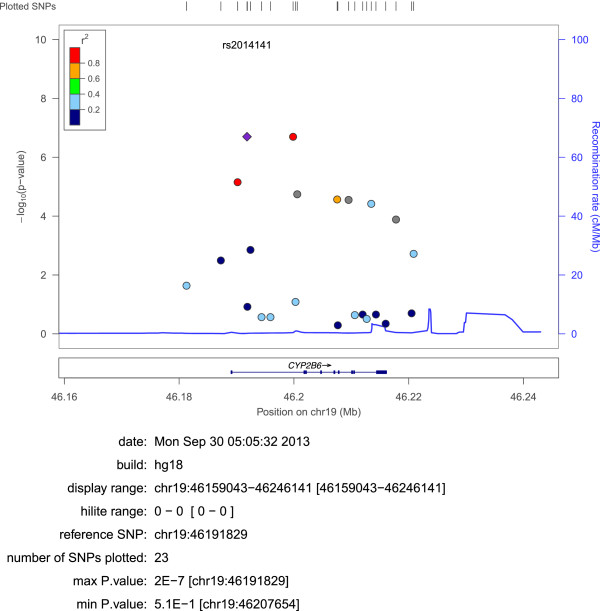
Association signal plot for SNPs mapping to CYP2B6. Each point represents a SNP in the association analysis, plotted with their p-value (on a -log10 scale) as a function of genomic position (NCBI Build 36). The lead SNP (with maximal association signal) is represented by the purple symbol. The shape of the plotting symbol corresponds to the annotation of the SNP: square for synonymous or UTR; and circle for intronic or non-coding. The colour coding of all other SNPs indicates LD with the lead SNP (estimated by CEU r2 from Phase II HapMap): red r2 ≥ 0.8; gold 0.6 ≤ r2 < 0.8; green 0.4 ≤ r2 < 0.6; cyan 0.2 ≤ r2 < 0.4; blue r2 < 0.2; grey r2 unknown. Recombination rates are estimated from Phase II HapMap and gene annotations are taken from the University of California Santa Cruz genome browser.